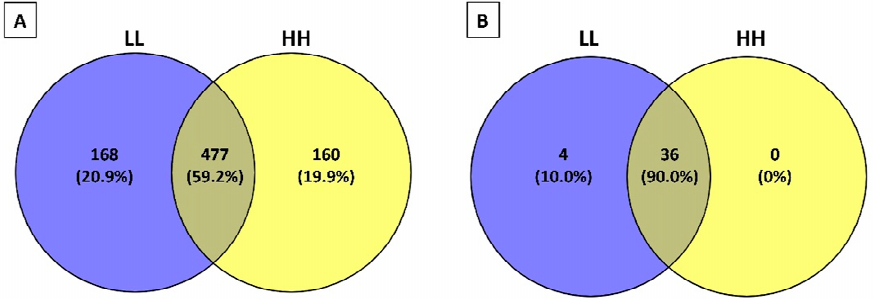
Figure 2. Venn diagrams of peptides obtained from Parmigiano-Reggiano (PR) peptide fractions. ( A ) Venn diagram created with all the identified peptides in the 12 PR peptide fractions (see online supplementary material Table S1 for the peptide sequences). ( B ) Venn diagram created with bioactive peptides identified in the 12 PR peptide fractions (see Table 1 for the peptide sequences). HH represents the samples belonging to the high-salt and high-fat group. LL represents the samples belonging to the low-salt and low-fat group. Table 1. List of the bioactive peptides found in the peptide fractions of Parmigiano Reggiano (PR) samples at 12 months of ripening a .